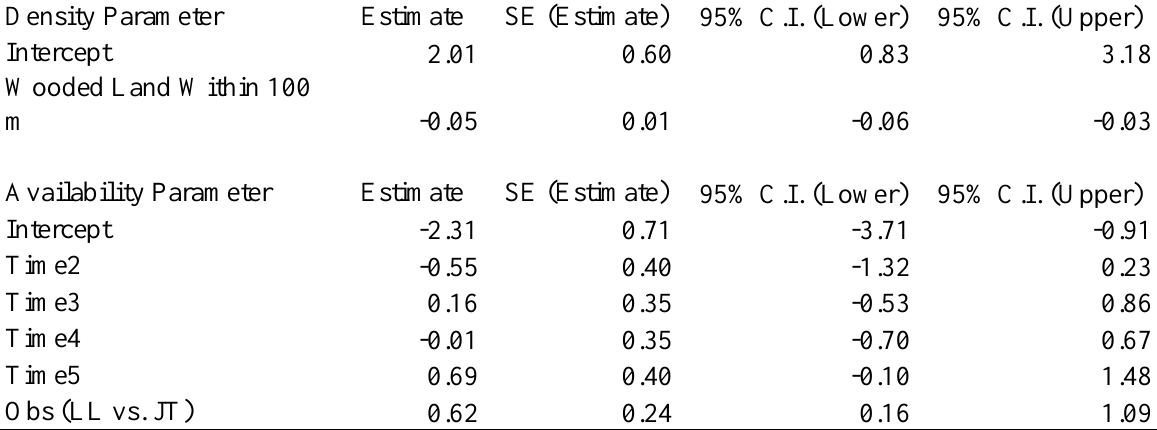
Table A2.I . Second-highest-ranking hierarchical distance-sampling model (AIC ∆ AIC =0.31, AIC weight=0.17) for Savannah Sparrows along 34 transmission line study sites in c Winnipeg, Manitoba, Canada in 2007 (n=102 surveys), assuming a uniform detection probability with increasing distance of birds from the transect line and effects of time of morning and observer experience but not Julian date on availability for